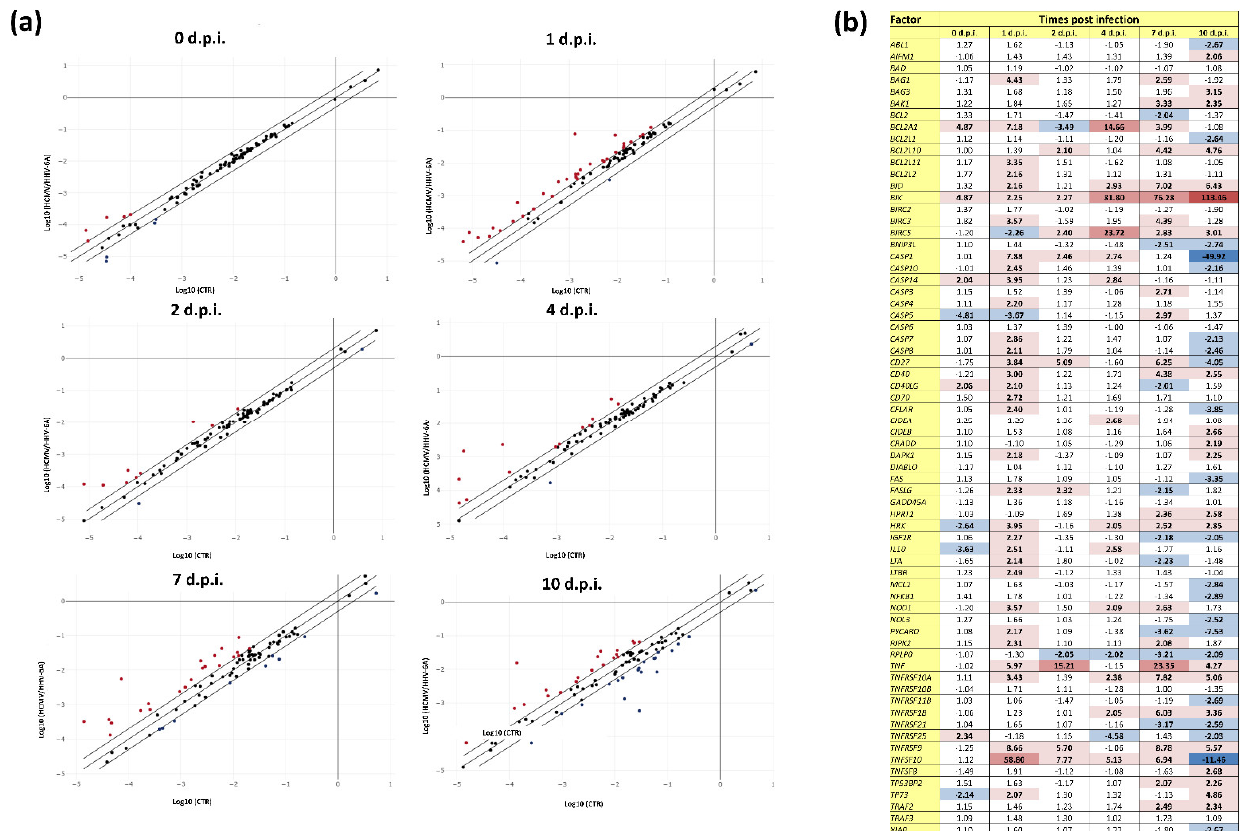
Figure 3. Expression of apoptosis-associated factors in response to HCMV/HHV-6A coinfection of human dermal fibroblasts. Cell samples were collected at the indicated days post-infection (d.p.i.) and analyzed by qPCR microarray. ( a ) Scatterplot representation: the threshold was at 2-fold change in infected vs. control cells; red and blue dots represent up-regulated and down-regulated factors, respectively; results are expressed as mean values of duplicate samples in two independent experi- ments. ( b ) Detailed values of down- and up-regulated factors: dark blue, down-regulation >10-fold; light blue, down-regulation between 2- and 9.9-fold; light red, up-regulation between 2- and 9.9-fold; red, up-regulation between 10- and 99.9-fold; dark red, up-regulation >100-fold. All values above the 2-fold threshold are indicated in bold.